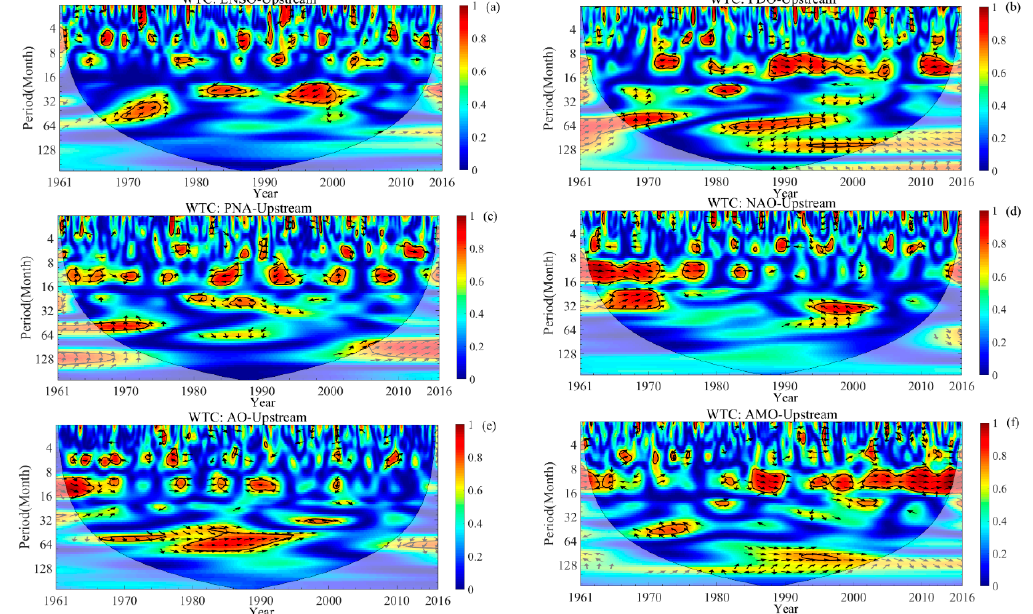
Figure 8. The wavelet coherence spectra between monthly observed average precipitation and El Niño-Southern Oscillation (ENSO) ( a ), Pacific Decadal Oscillation (PDO) ( b ), Pacific North American teleconnection pattern (PNA) ( c ), North Arctic Oscillation (NAO) ( d ), Atlantic Oscillation (AO) ( e ), and Atlantic Multidecadal Oscillation (AMO) ( f ) indices covering 1961–2016 in the upper Heihe River Basin (UHRB). The 5% significance level against red noise is exhibited as a thick contour, and the relative phase relationship is denoted by arrows (The arrows pointing to the right for positive correlation and to the left for negative correlation. The arrows pointing vertically downward or upward represent the advanced or lagged correlation with precipitation and the climate indices of the 1/4 cycle).